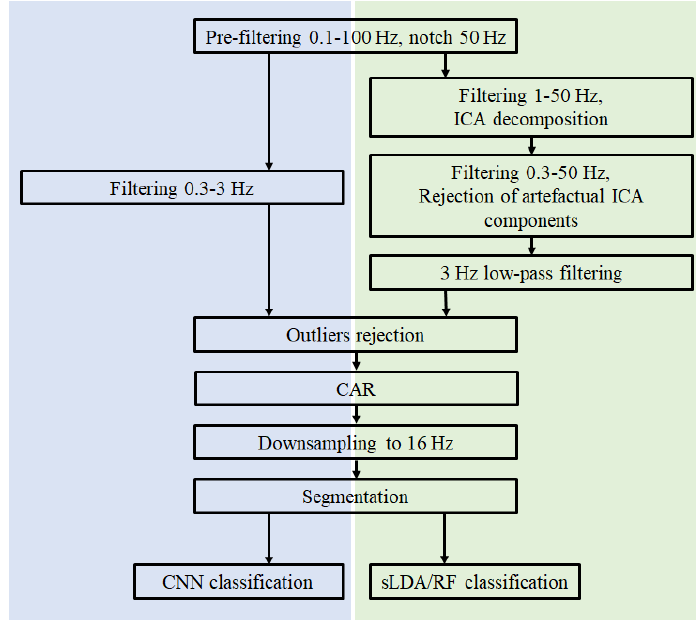
Figure 1. Pre-processing